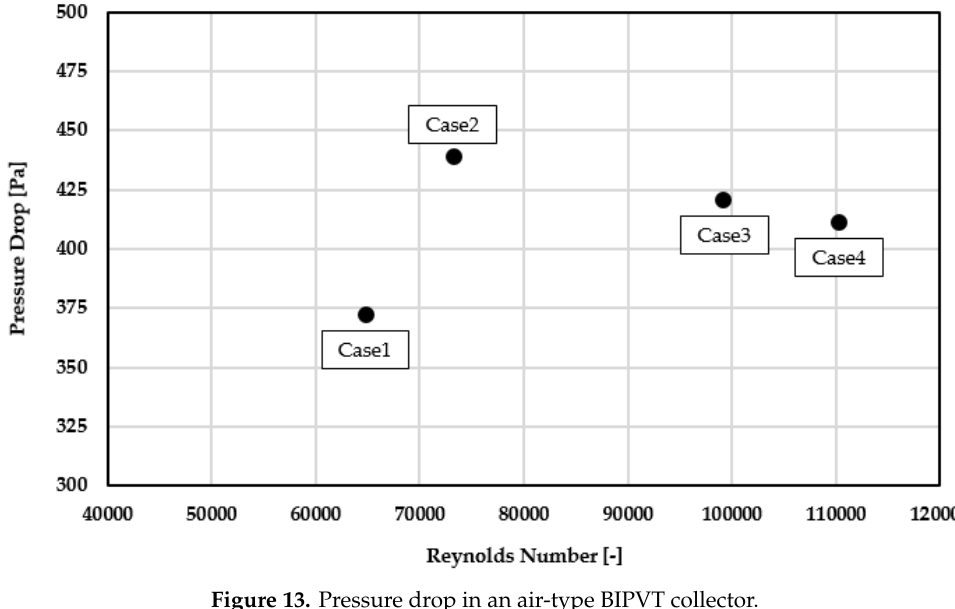
Figure 13. Pressure drop in an air-type BIPVT collector. Table 3. The thermal e ffi ciency of an air-type BIPVT